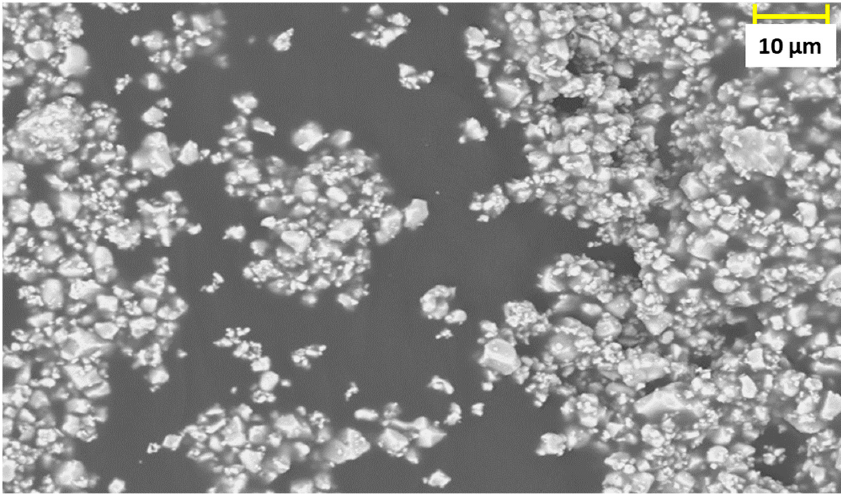
Figure 3. SEM picture, taken in back scattered electrons mode (BSE) of PZT fillers.